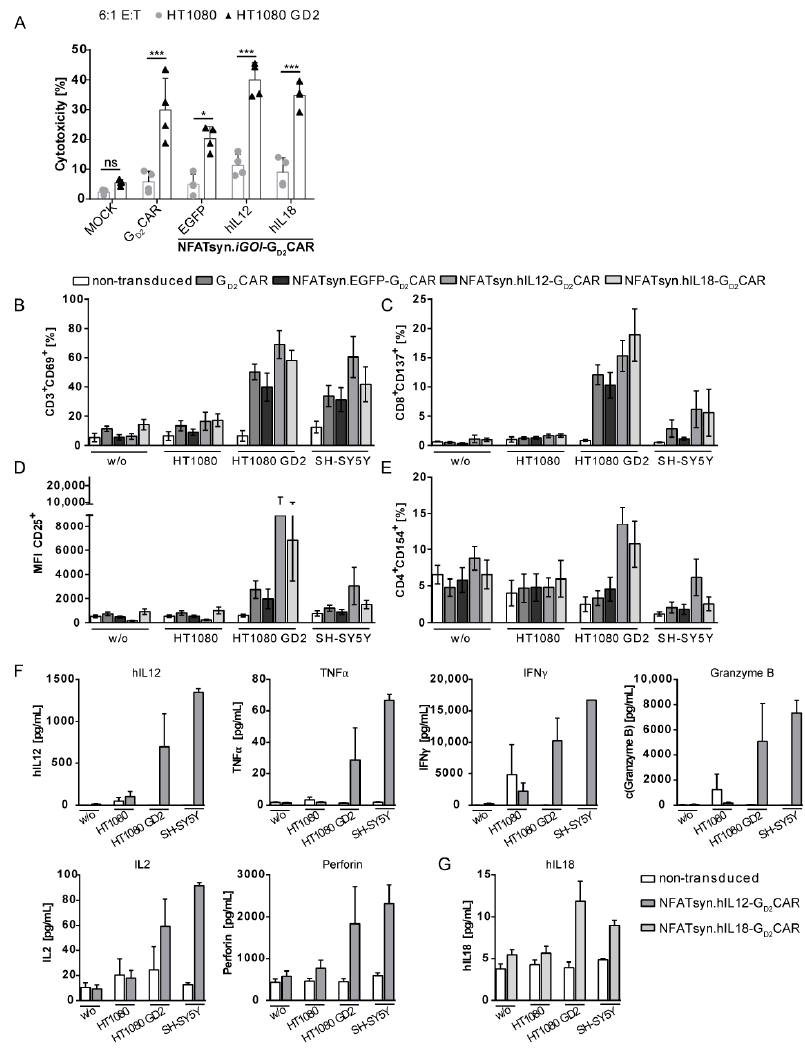
Figure 6. Cytotoxicity and activation marker analyses of “all-in-one” NFATsyn.iGOI-G D2 CAR constructs-transduced primary T cells. ( A ) G D2 CAR-specific signaling leads to target cell-specific killing. Lactate dehydrogenase (LDH) assay with supernatants of distinct “all-in-one” vector construct co-cultures. Cytotoxicity of sorted transduced primary human CD4 + /CD8 + T cells (MOI 3) after 48 h co-culture with HT1080 and HT1080 GD2 target cells in a 1:6 effector/target (E/T) ratio. Shown are mean values ± SD (symbols indicate individual donors; n = 4). Indicated significance was determined by two-way ANOVA with Bonferroni´s multiple comparison test; *** p ≤ 0.001;; * p ≤ 0.05; ns > 0.05. ( B – E ) Flow cytometric analysis of T cell-specific activation marker of sorted “all-in-one” vector construct transduced primary human T cells after 48 h co-culture with indicated target cell lines in a 6:1 E/T ratio. ( B ) Percentage of CD3 + CD69 + T cells; ( C ) percentage of CD8 + CD137 + T cells; ( D ) mean fluorescent intensity (MFI) of CD25 + T cells; ( E ) percentage of CD4 + CD154 + T cells after co-culture. Shown are mean values ±SD (symbols indicate individual donors; n = 5). ( F ) Cytokine analysis of co-culture supernatants harvested after G D2 CAR-specific activation of human CD4 + /CD8 + T cells transduced with “all-in-one” vector constructs. Cytokine concentrations were determined after 48 h co-culture experiments of transduced primary T cells stimulated with indicated target cells in a 6:1 E/T ratio using a customized LEDGENDplex™ Multi-Analyte Flow Assay (BioLegend), which allowed simultaneous detection of human IL12, tumor necrosis factor (TNF) α , Interferon (IFN) γ , granzyme B, IL2, and perforin. ( G ) Detection of human IL18. Shown are mean values ±SD (symbols indicate individual donors; n = 5).